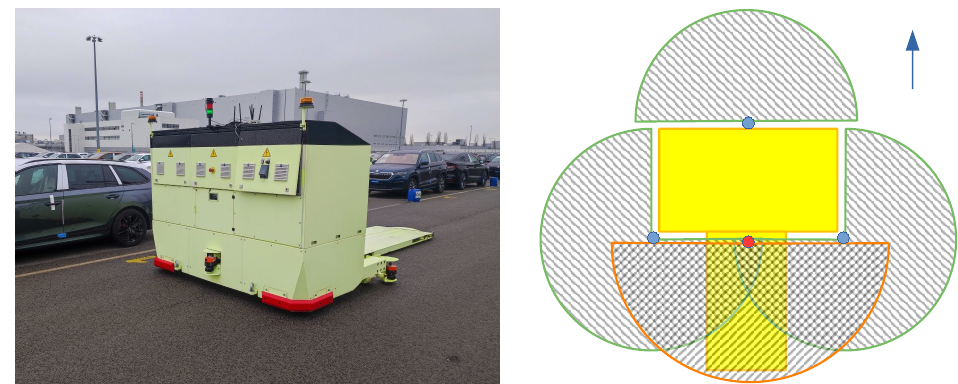
Figure 1. The pipeline was tested on a car transporter visible here in light rain on the left. Also visible are two of the four planar laser scanners positioned at ground level, located at the front, sides, and back of the robot. A visualisation of the positioning of the laser scanners and their field of view relative to the robot can be seen on the right, with the three SICK MICS3 sensors visible in green, and the SICK LMS111 sensor visible in red (sensor range not to scale). The arrow indicates the forward direction of the